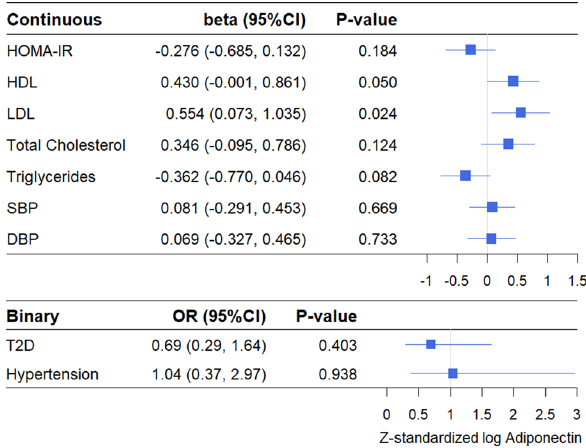
Figure 3. Causal associations between adiponectin and cardiometabolic outcomes using the two-stage least-squares method. Values are presented are adjusted for age, sex, population stratification, BMI, alcohol consumption, and smoking. SBP and DBP are additionally adjusted for blood pressure medication use. HOMA-IR and Triglycerides were log transformed. All continuous variables were Z-standardized. T2D cases were excluded for all HOMA-IR analyses.